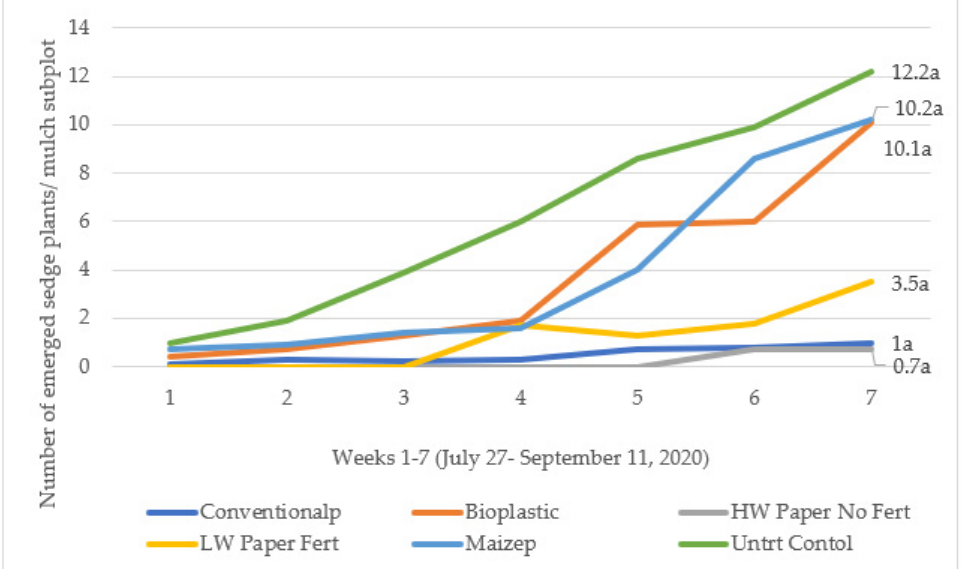
Figure 4. Individual sedge plants coming through the mulch treatments at the Beaumont, MS location. Mulch treatments with different letters are statistically significant at p ≤ 0.05 using SAS Proc GLM with Duncan. Untrt Control = un-mulched raised beds; Maize p = biodegradable maize plastic mulch; Bioplastic = biodegradable bioplastic mulch; Conventional p = polyethylene black plastic mulch; HW Paper No Fert = heavy weight paper mulch without impregnated fertilizer; LW Paper Fert = light weight paper mulch with impregnated 3–3-3 fertilizer within the mulch.